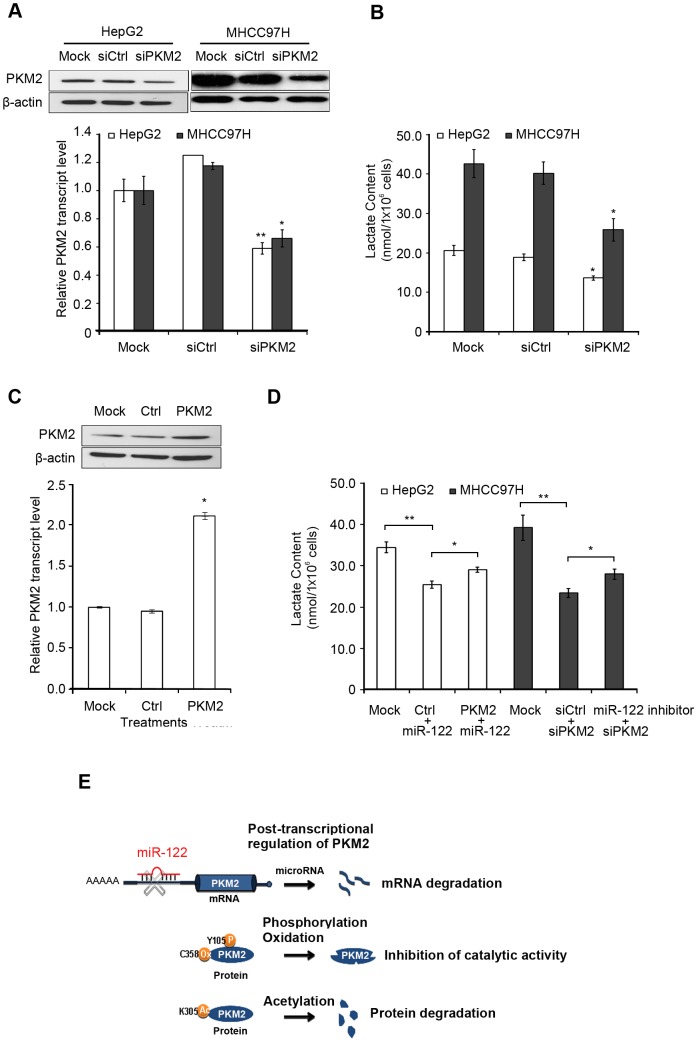
Repression of PKM2 underlies miR-122-dependent phenotypes in vitro.
(A) Protein (upper panel) and mRNA levels (lower panel) of PKM2 in HepG2 or MHCC97H after transfection with siRNA targeted to PKM2 (siPKM2) or with siRNA control (siCtrl). (B) Lactate content of cells after siPKM2 or siCtrl transfection. Data were derived from three independent experiments. (C) Protein (upper panel) and mRNA levels (lower panel) of PKM2 after transfection of PKM2 expression plasmid (PKM2). (D) The reduction of lactate content upon transfection of miR-122 expression plasmid (miR-122) or siPKM2 was abolished with co-transfection of PKM2 or miR-122 inhibitor, respectively (compared to mock). (E) Hypothetical model of miR-122 targeting PKM2 in HCC metabolisms. *p<0.05, ** p<0.01, Error bars represent S.E.M.